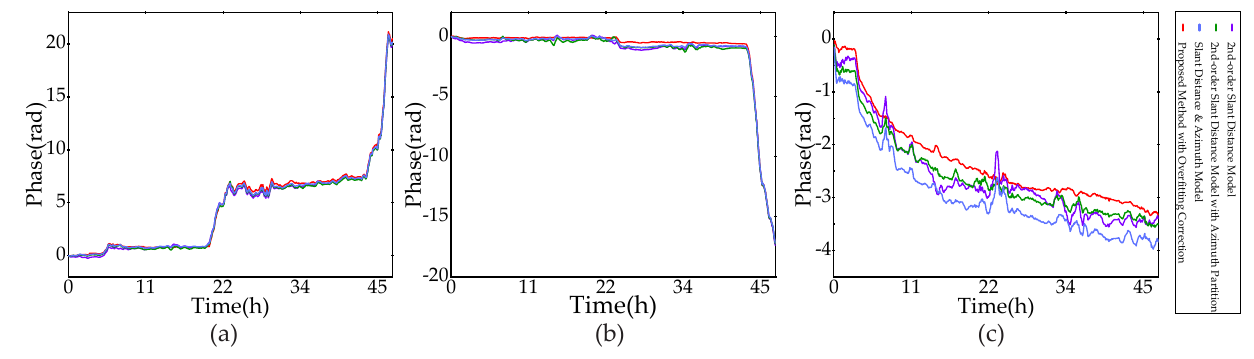
Figure 25. Corrected CP median curves of ( a ) #3, ( b ) #4, and ( c ) #7 in Figure 24 . Figure 25, indicates that the curves of the conventional methods have obvious spikes in the interval with violent atmospheric changes, while the curves of the proposed method are smoother and consistent with the findings of the experiment in Section